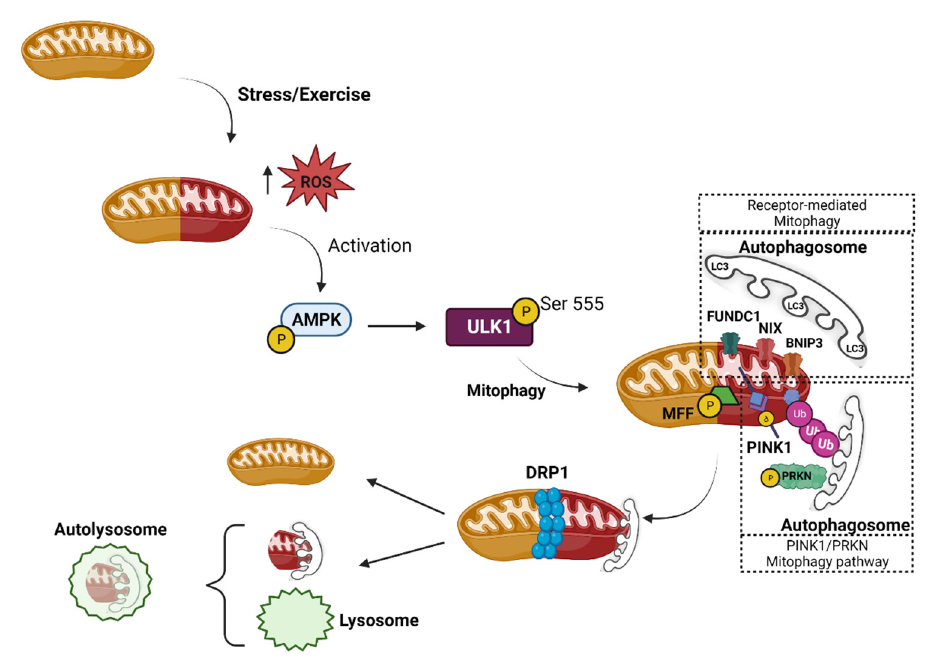
Figure 2. Exercise-induced mitophagy. During exercise-induced energetic/oxidative stress, the damaged and dysfunctional mitochondria (represented by the transition of their color from orange to red) are removed from muscle cells. Acute exercise causes mitochondrial stress and activates the removal of damaged/dysfunctional reticulum regions via mitochondrial fission and mitophagy. When the inner mitochondrial membrane potential is disrupted, the production of mitochondrial- derived reactive oxygen species (mtROS) increases, activating the AMP-activated protein kinase (AMPK)/Unc-51-like autophagy activating kinase 1 (ULK1) signaling pathway. While PTEN-induced kinase 1 (PINK1) phosphorylates Parkin (PRKN) to initiate the mitophagy process (PINK1/PRKN pathway), the exercise-induced AMPK activation promotes the formation of autophagosomes through an ULK1-mediated mechanism. AMPK phosphorylates mitochondrial fission factor (MFF) to stimulate mitochondrial fission through the activation of dynamin-related protein 1 (DRP1). The autophagosome/mitochondria complexes then fuse with lysosomes to complete the degradation of the damaged mitochondria.